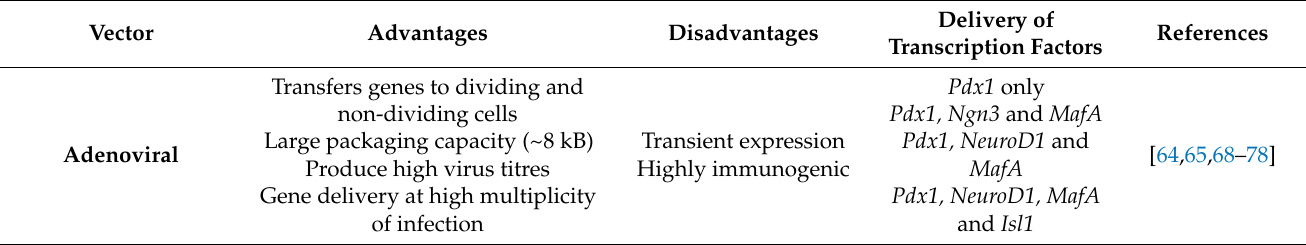
Table 1. Advantages and disadvantages of the use of viral vectors in gene therapy and their delivery of β -cell transcription factors to generate insulin-producing